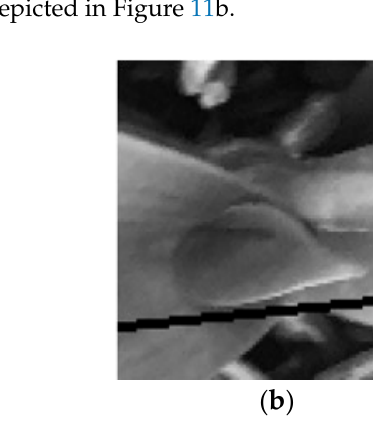
Figure 11. Fitted line effect: ( a ) Marked largest area; ( b ) fitted line. The desired watering point on the stem-root junction is calculated after obtaining the actual 3D coordinates of the center point and the leaf vector. Through the